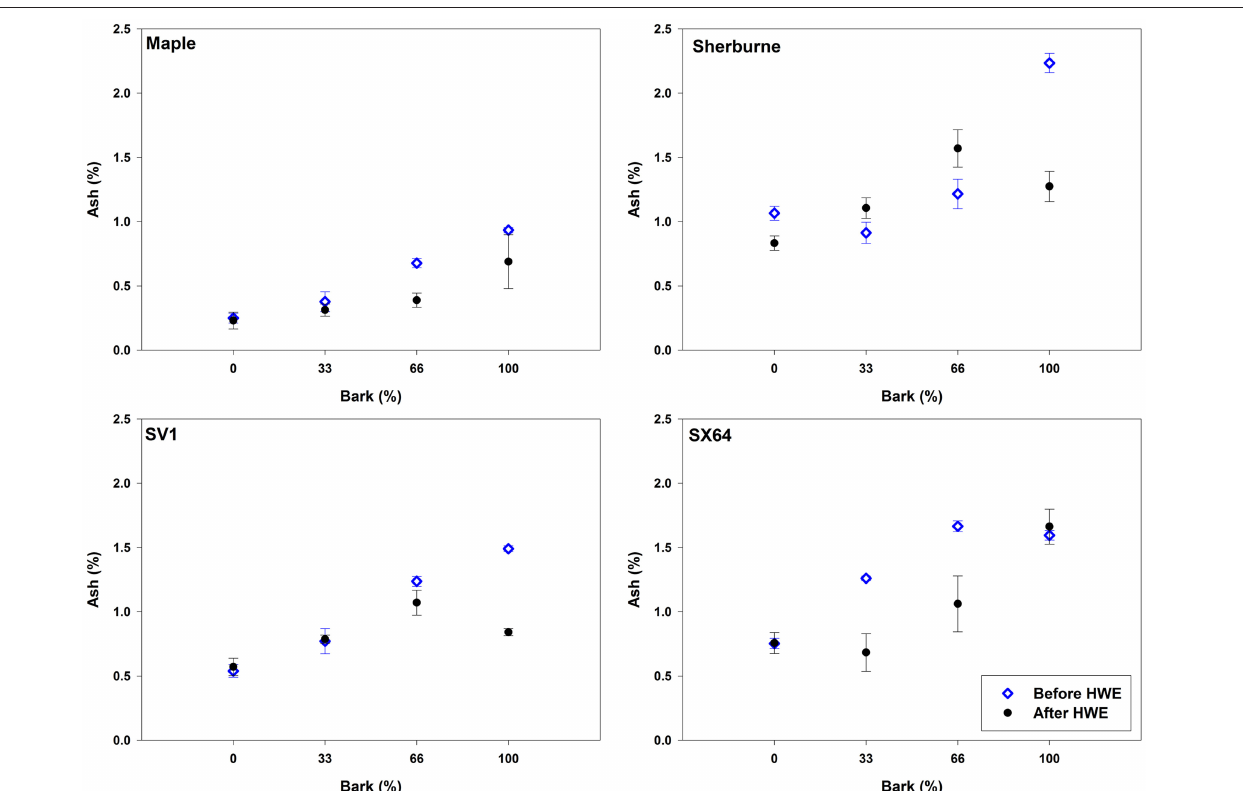
levels of bark except for 100% SV1, which was not significantly different ( p =